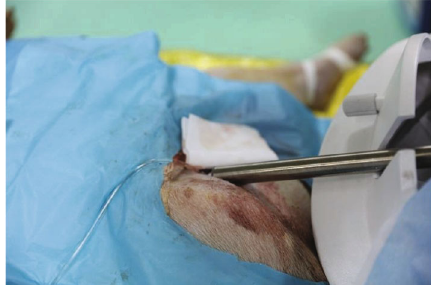
Figure 4: The joint between the manipulator arm of the slave end and the femoral artery sheath.